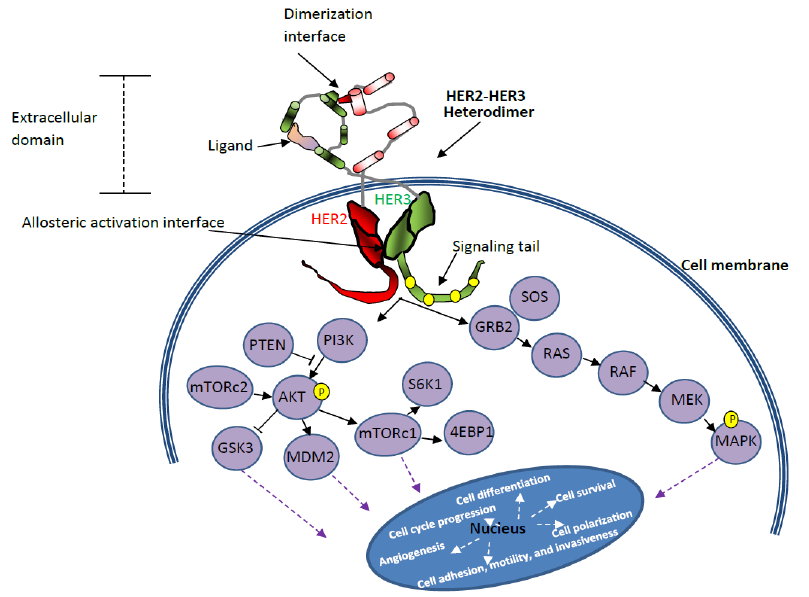
Figure 2. HER2–HER3 heterodimer and HER2 pathway. The main elements of this pathway are phosphoinositide-3-kinase (PI3K), phosphatase and tensin homolog (PTEN), protein kinase B homolog (AKT(PKB)), glycogen synthesis kinase (GSK), mouse double minute-2 homolog (MDM2), mammalian target of rapamycin complex-1,2 (mTORc1,2), ribosomal protein S6 kinase beta-1 (S6K1),